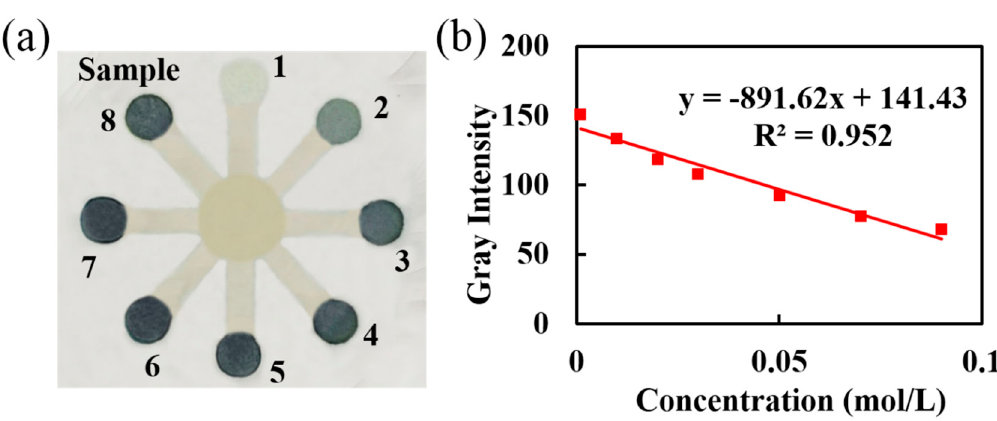
Figure 10. Colorimetric assay for iron ion concentration. ( a ) Image of testing regions on three-dimensional nanofiber-based microfluidic analysis devices (3D-µNMADs); ( b ) linear curve fit for gray intensity vs. iron ion concentration.